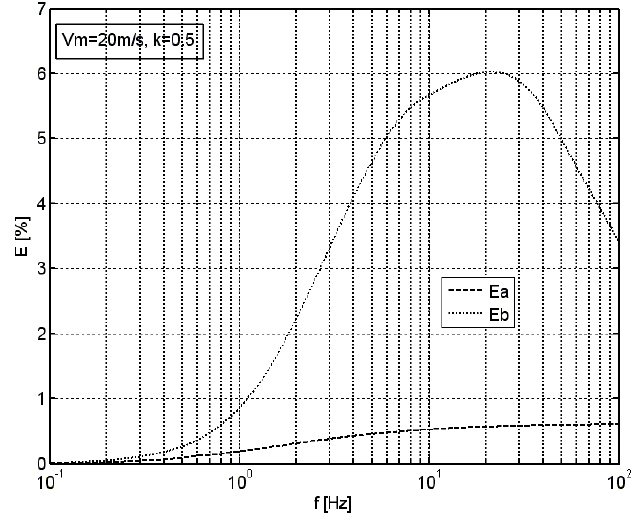
Figure 4. Relative error of the average velocity measured by an anemometer with ( Ea ) or without ( Eb ) the optimization system in the function of the frequency of sinusoidal excitation, v m = 20 m/s, k = 0.5.